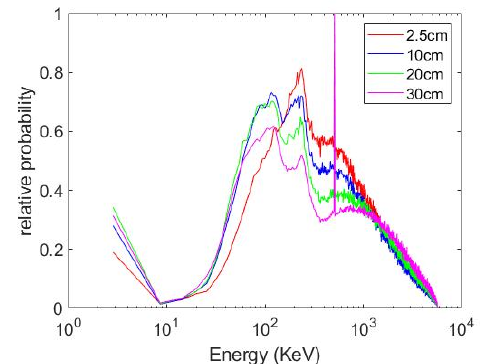
Figure 6. Megavoltage (MV) phase space files collected at various depths in water.